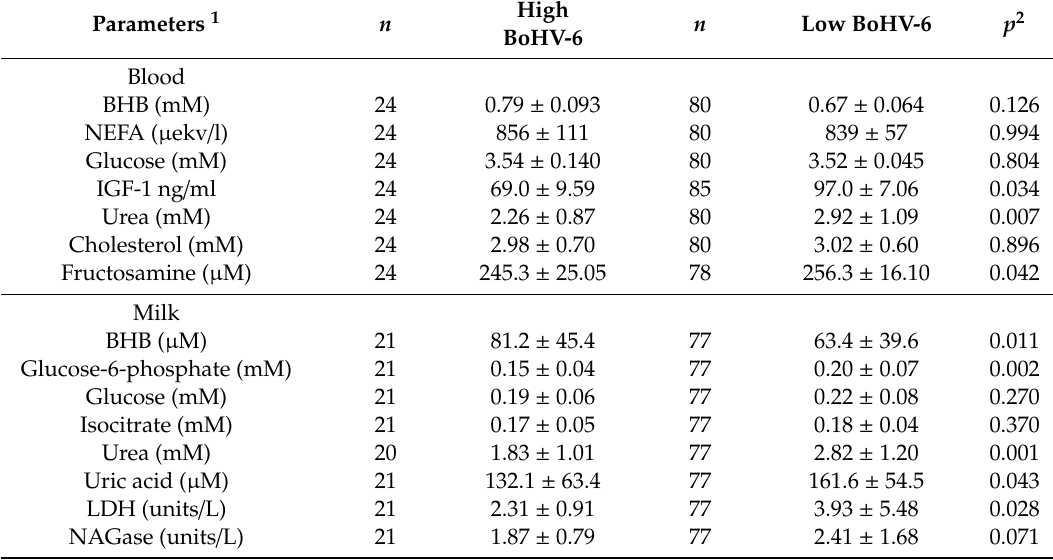
Table 3. Metabolite data (mean ± SD) measured in blood and milk from cows with high ( > 200) or low (1–200) BoHV-6 scores in early lactation. Parameters